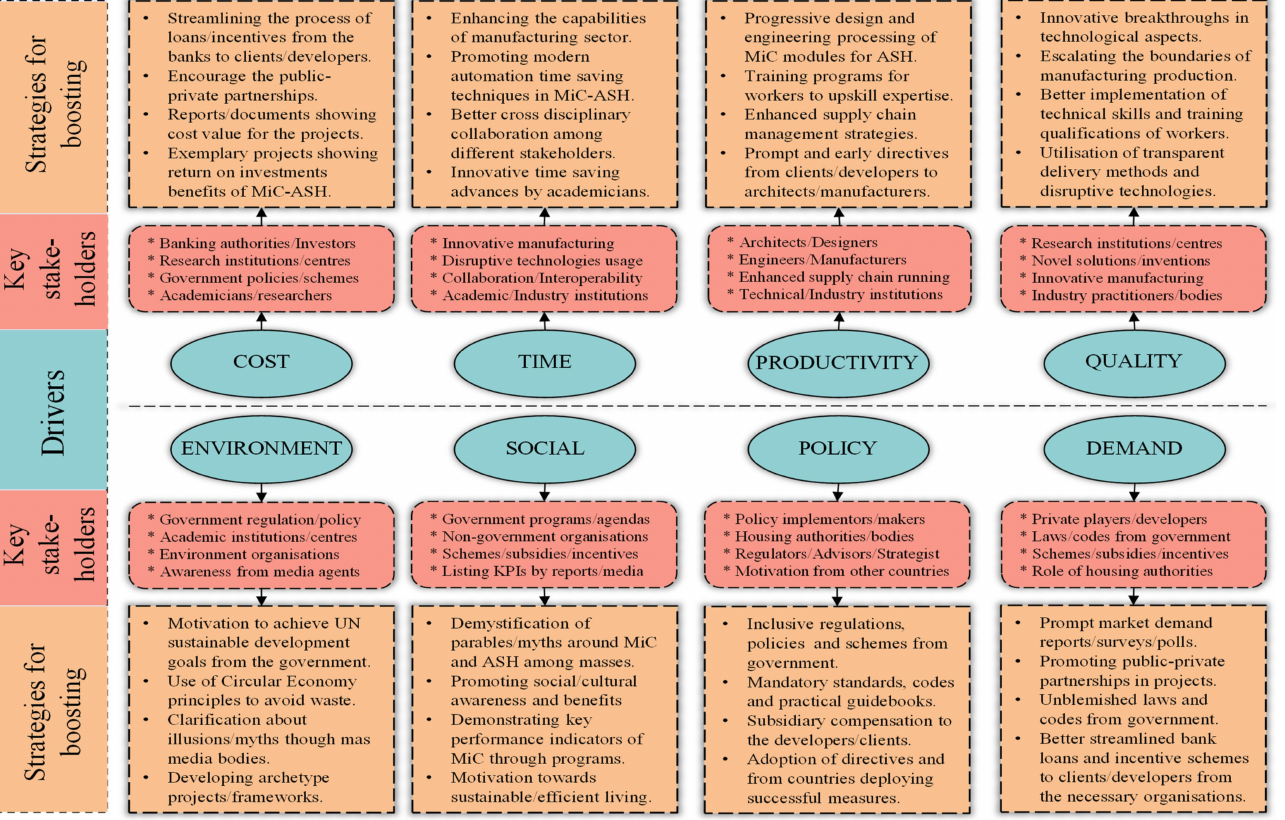
Figure 10. Strategic framework for boosting MiC-ASH integrity towards better